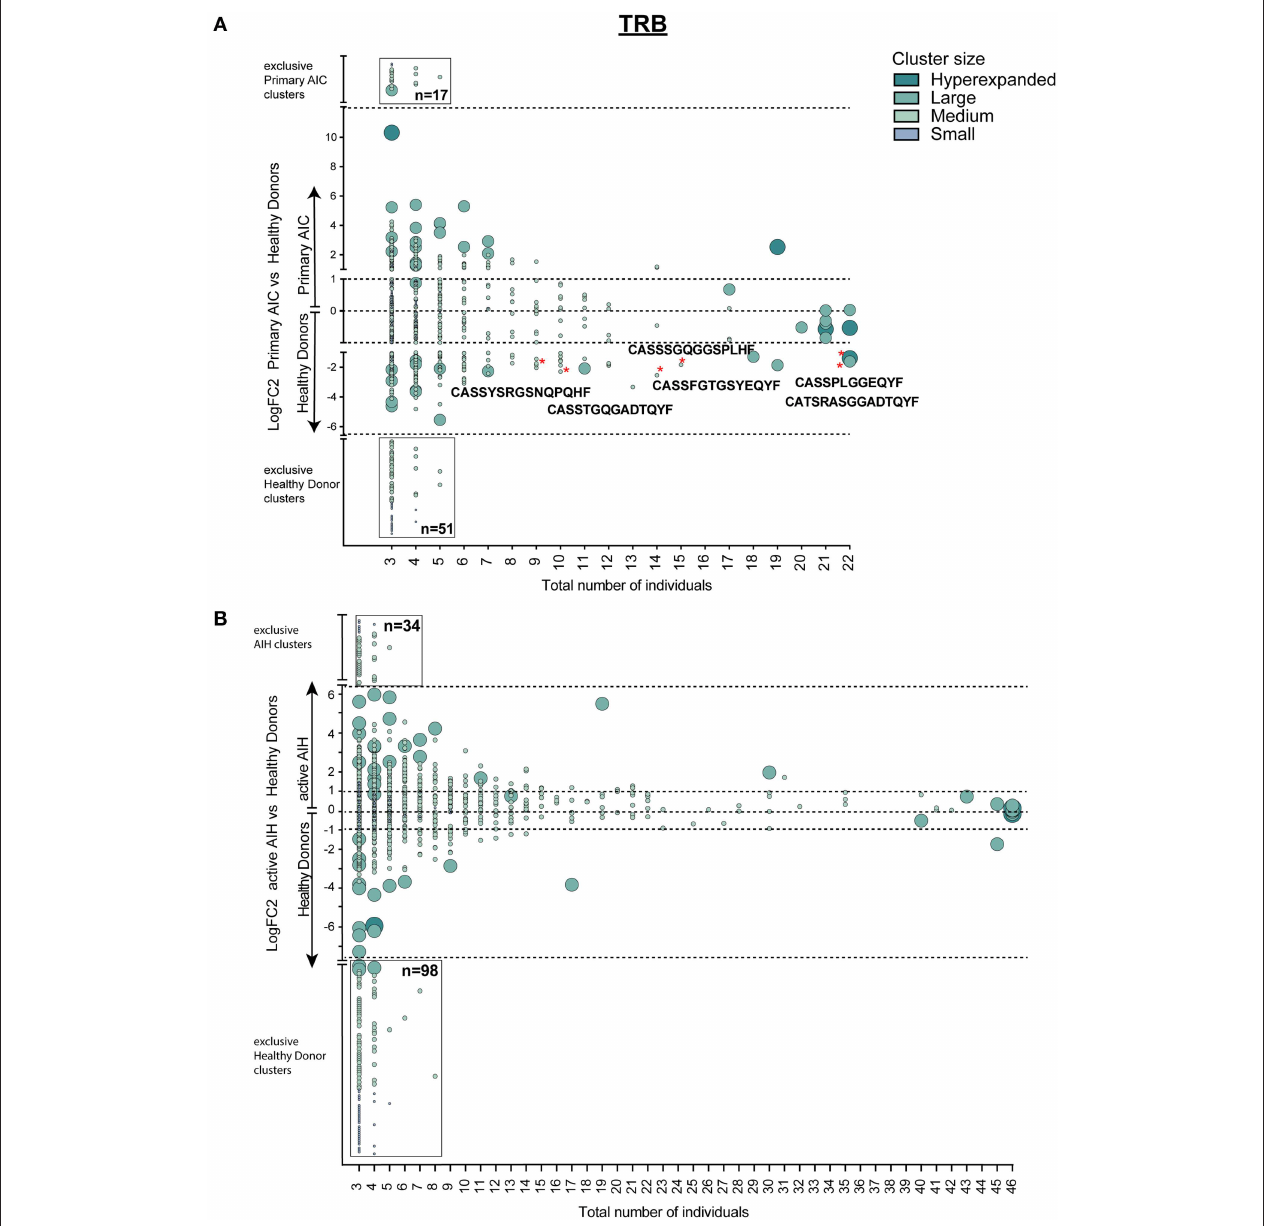
FIGURE 4 | Cluster analysis of autoimmune TRB repertoires. Logarithmic fold-change of clusters that were present in at least 3 individuals in (A) patients with primary AIC vs. HD and (B) patients with active AIH vs. HD. Cluster size and color represents mean frequency of CDR3 clones that constitute the respective cluster. Cluster sizes are defined as hyperexpanded (0.01 < x ≤ 1), large (0.001 < x ≤ 0.01), medium (1E-04 < x ≤ 0.001), small (1E-05 < x ≤ 1E-04). Significantly different abundant cluster were marked with *and their respective cluster sequence. Statistical test: Wilcoxon-rank test. * p ≤